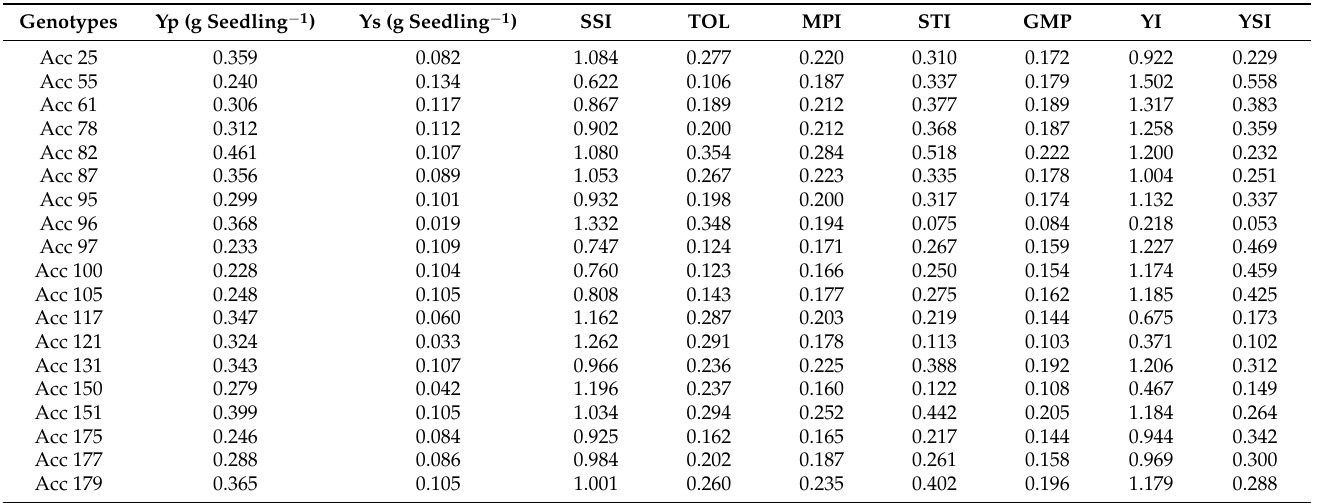
Table 4. Drought stress tolerance indices of 24 Bambara groundnut genotypes evaluated under non- stressed and drought stress conditions. TOL; Tolerance, MPI; Mean Productivity Index, STI; Stress Tolerance Index, GMP; Geometric Mean Productivity, YI; Yield Index, YSI; Yield Stability Index, DRI; Drought Resistance Index, LSD; Least significance difference, CV; Coefficient of Variation, p -value; probability value Yp; yield under well-watered condition, Ys; yield under drought conditions, SSI; Stress Susceptibility